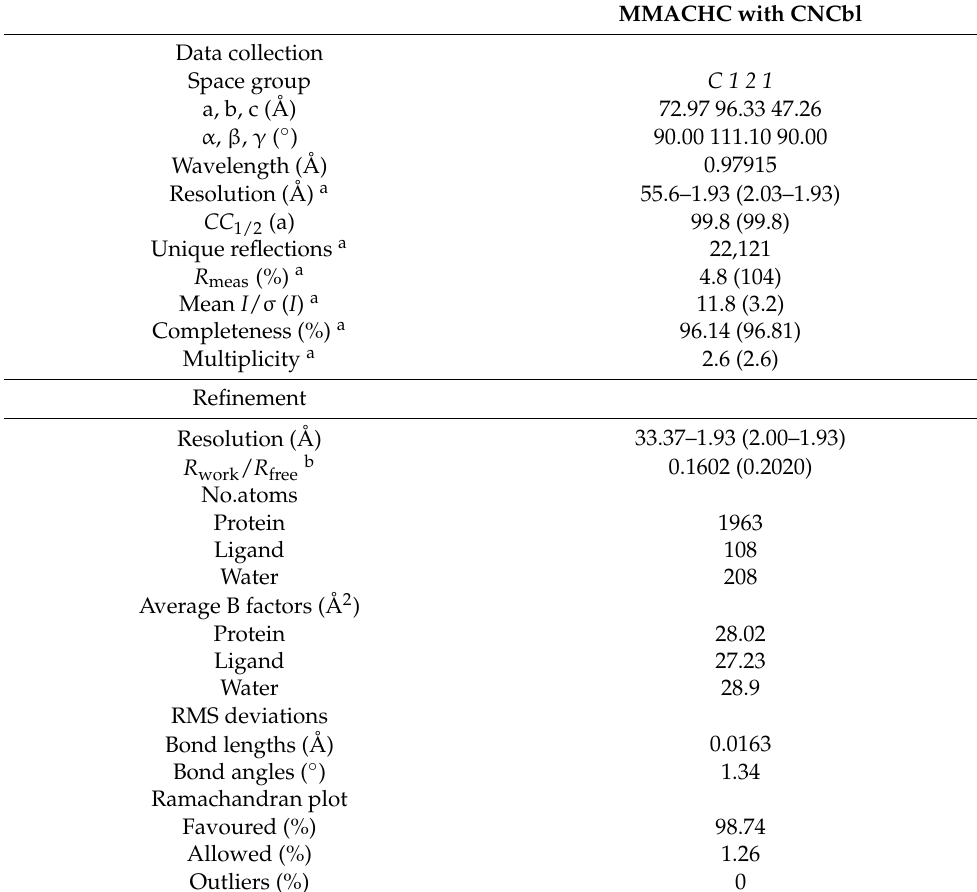
Table 1. Data collection and refinement